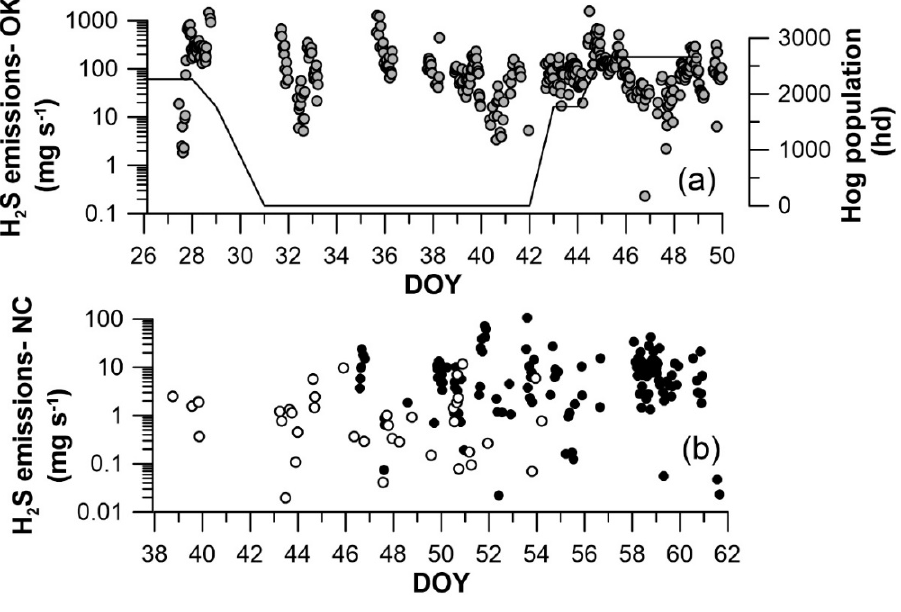
Figure 4. Influence of fresh manure loading on half-hourly lagoon emissions: ( a ) Variation in H 2 S emissions with population (solid line) of the three barns; ( b ) Variation in H 2 S emissions with (solid circles) and without (open circles) hogs in the barns.